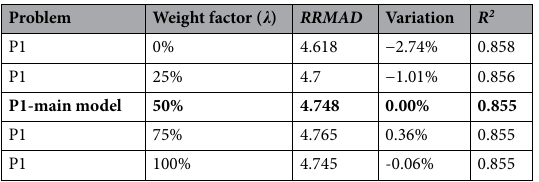
Table 8. Analyzing weight factor. Significant values are in bold.